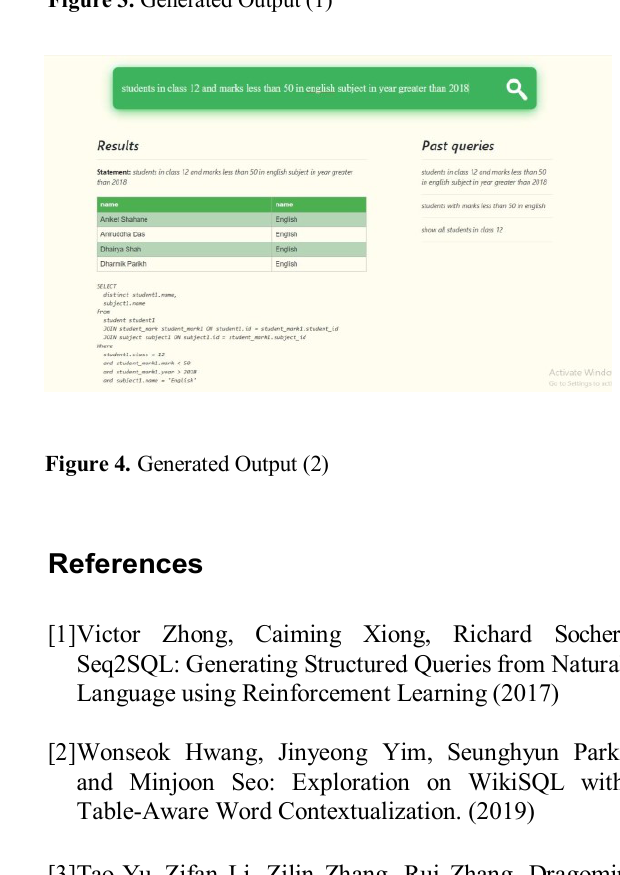
Figure 3. Generated Output (1)